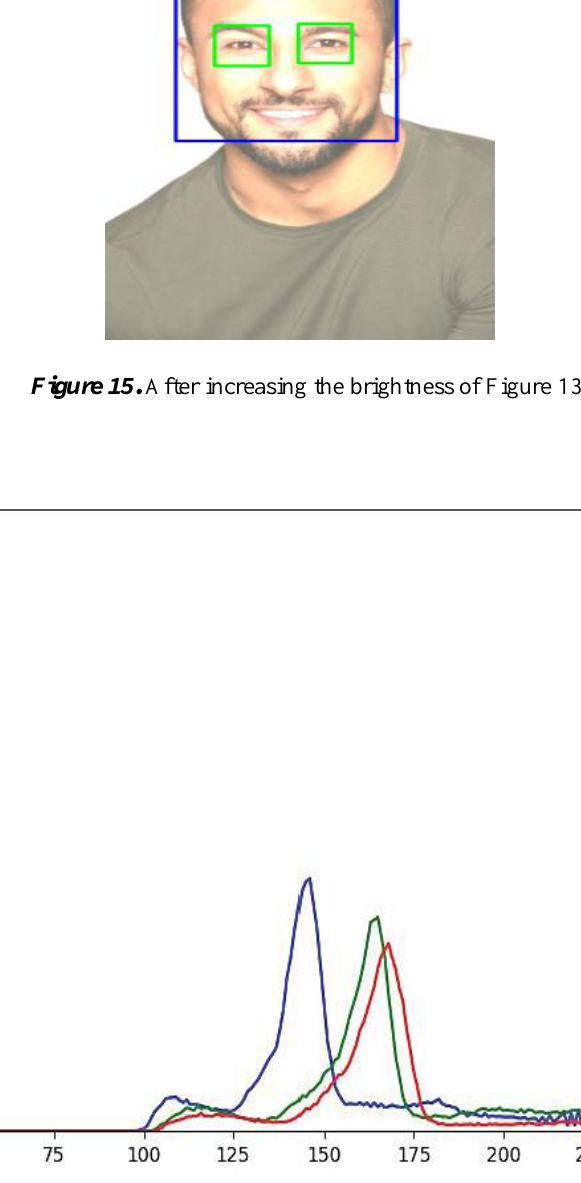
Figure 16. Histogram of the RGB graph for the image (see Figure